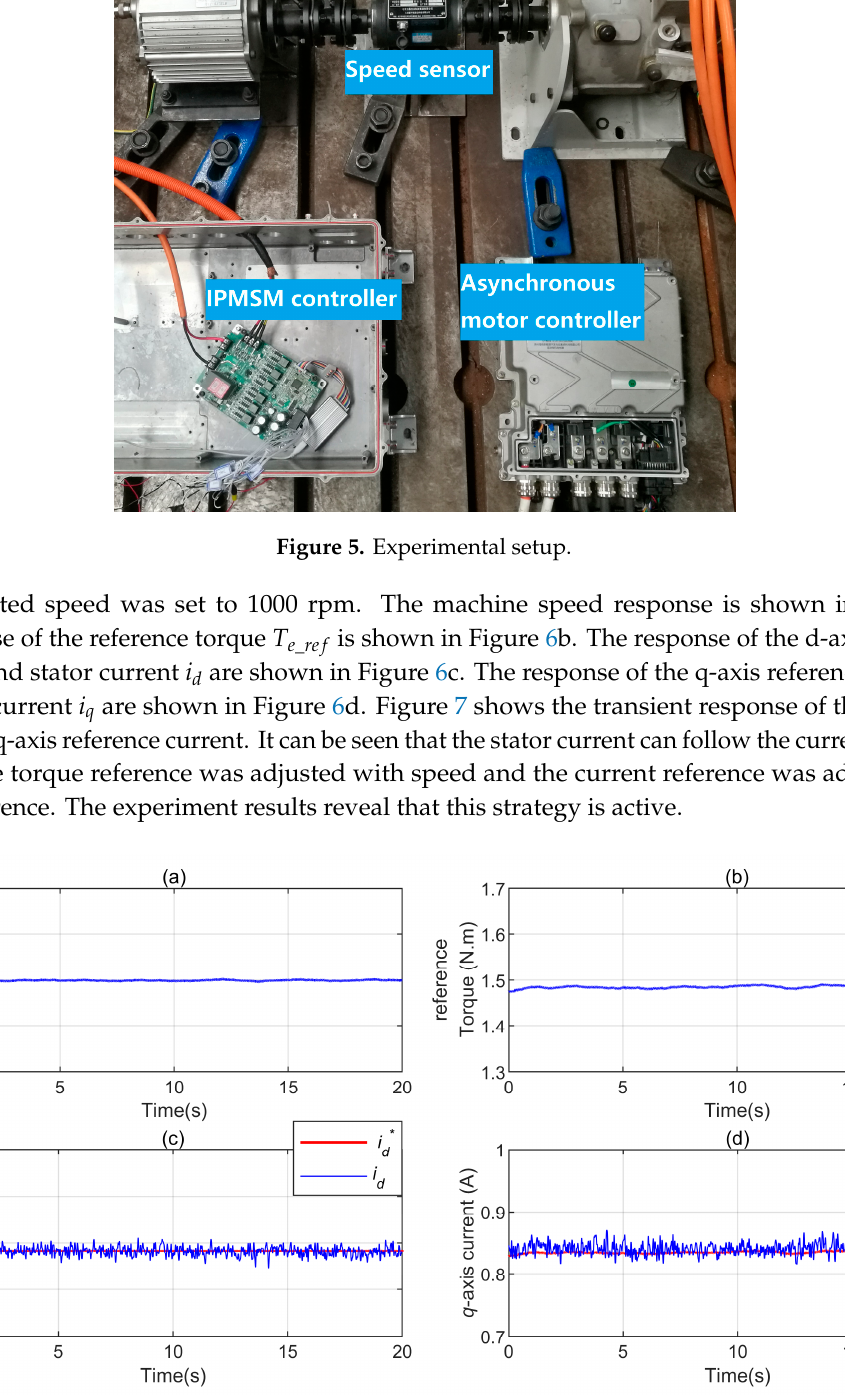
Figure 7. The experiment result: ( a ) reference torque; ( b ) q-axis reference current.